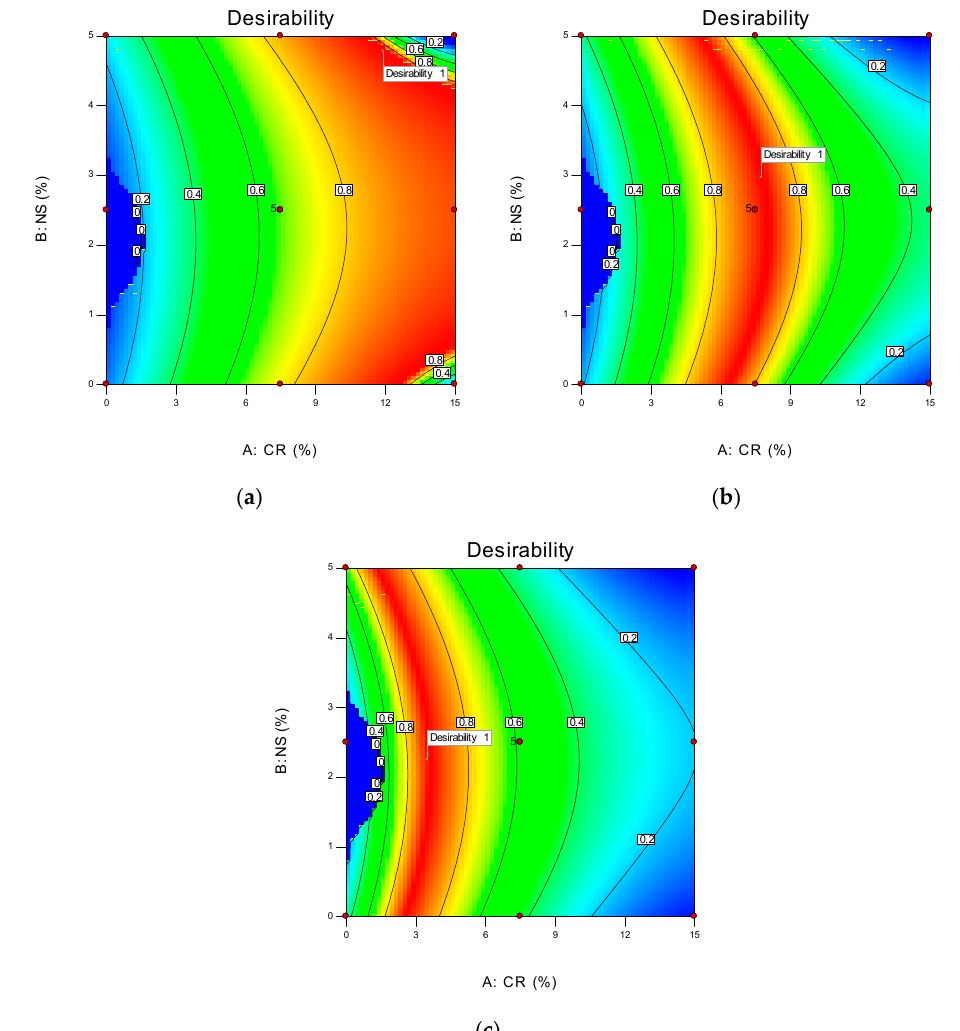
Figure 15. Desirable compressive strength of NS-CRM: ( a ) 20 MPa; ( b ) 35 MPa; ( c ) 50 MPa.